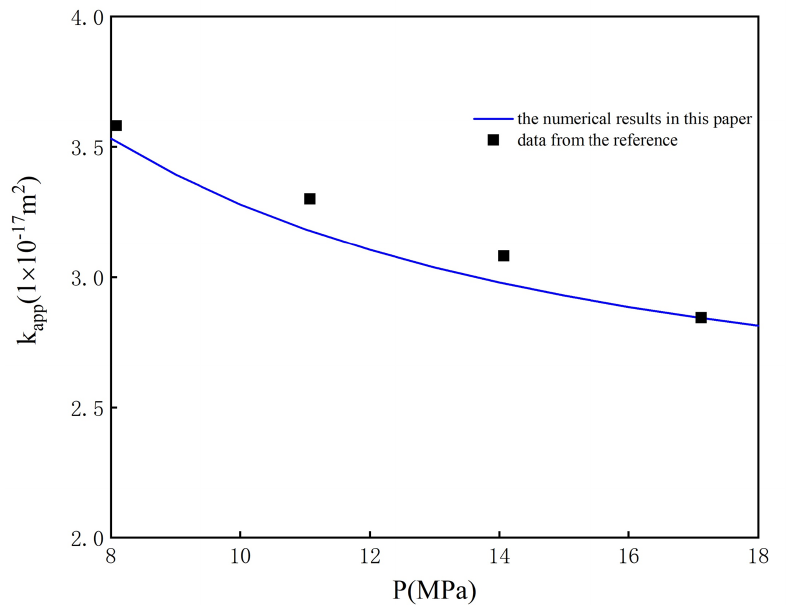
Figure 2. Comparison between the reference results and the numerical results in this paper.